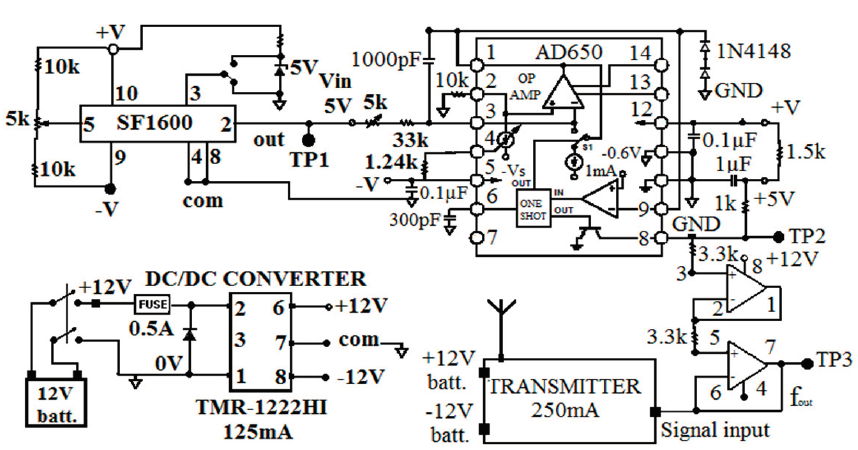
Figure 2. Circuit diagram of accelerometer transmitter